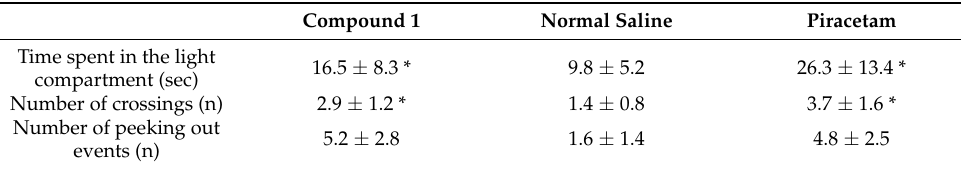
Table 3. Animal behavior in the light–dark box test